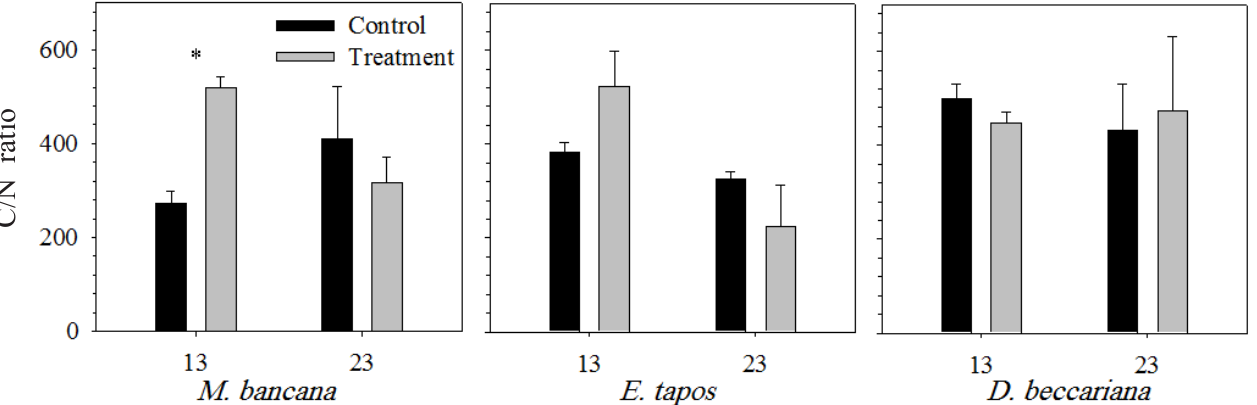
Fig 4. Mean C/N ratio across the species after 13 months and 23 months. Vertical bars indicate the standard error. Asterisks indicate significant differences (* p <